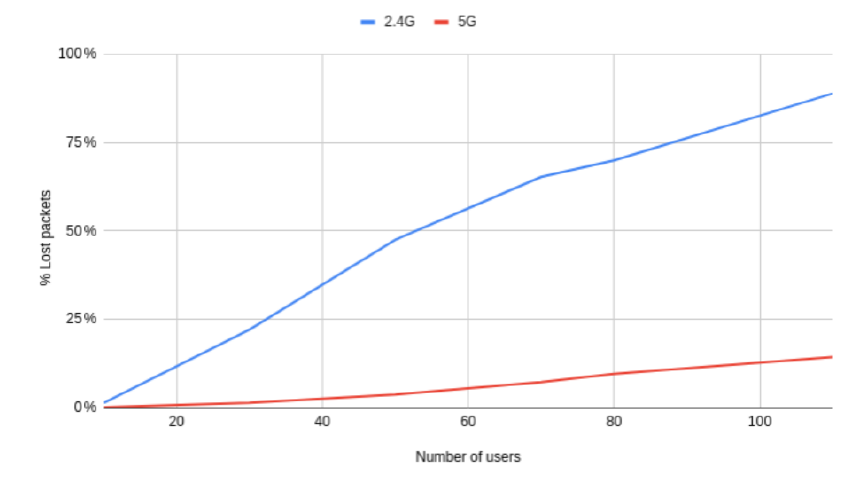
Figure 10. Linear representation of the number of packets lost over the number of